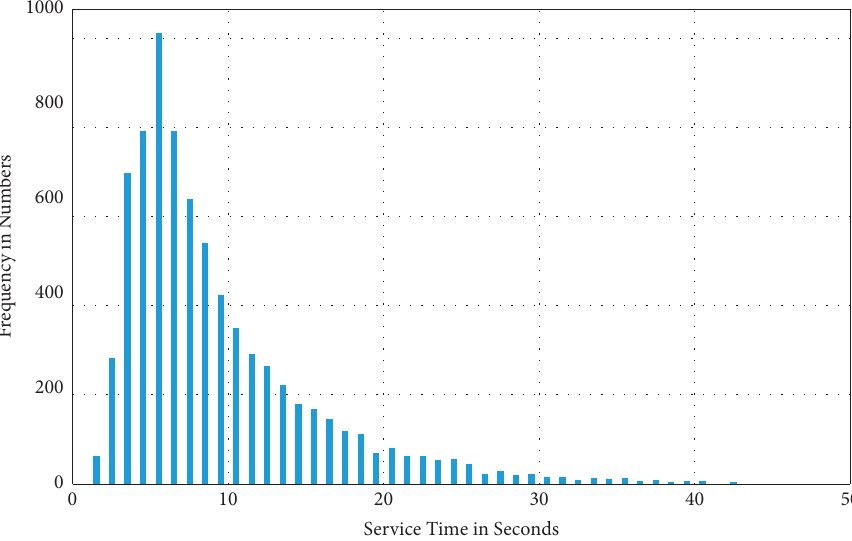
Figure 3: Frequent distribution of service time of lane 1# during the saturation